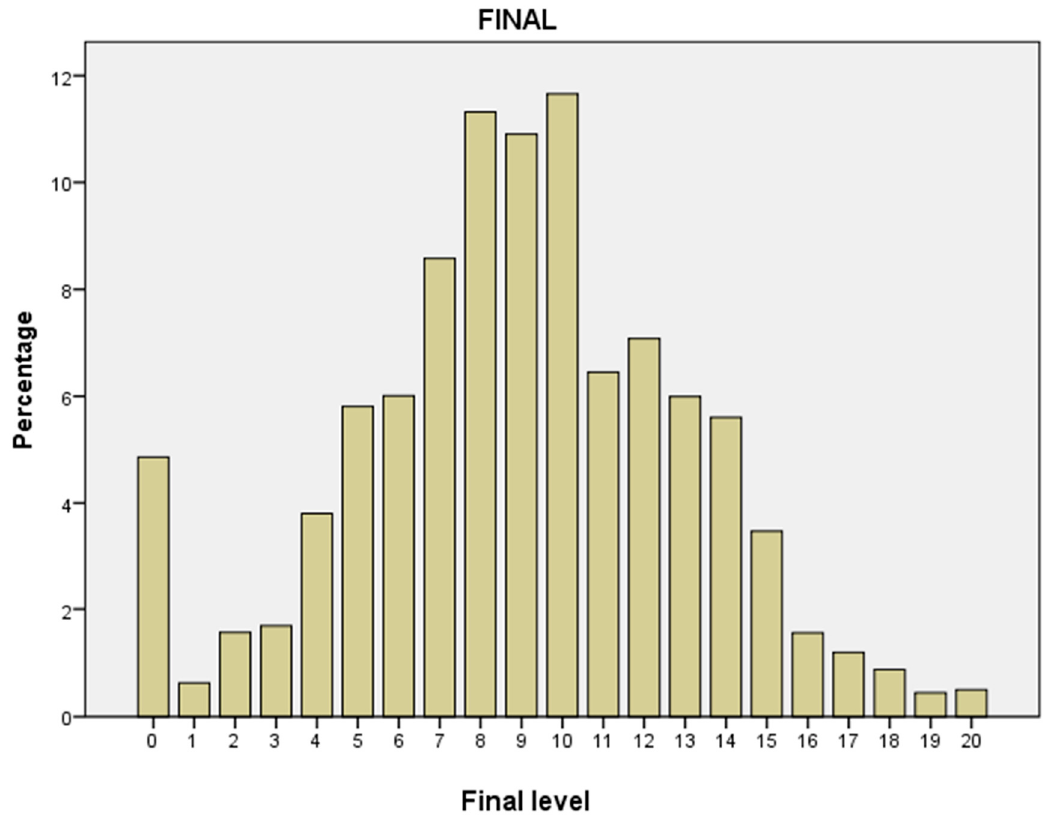
Figure 3. Percentages of students in each final level (FINAL).